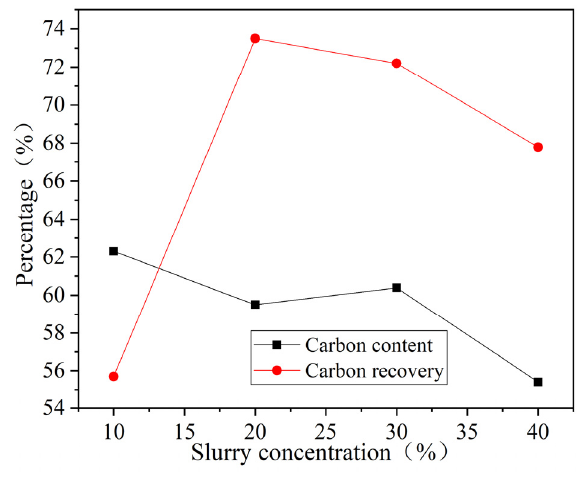
Figure 9. Effect of slurry concentration on flotation.